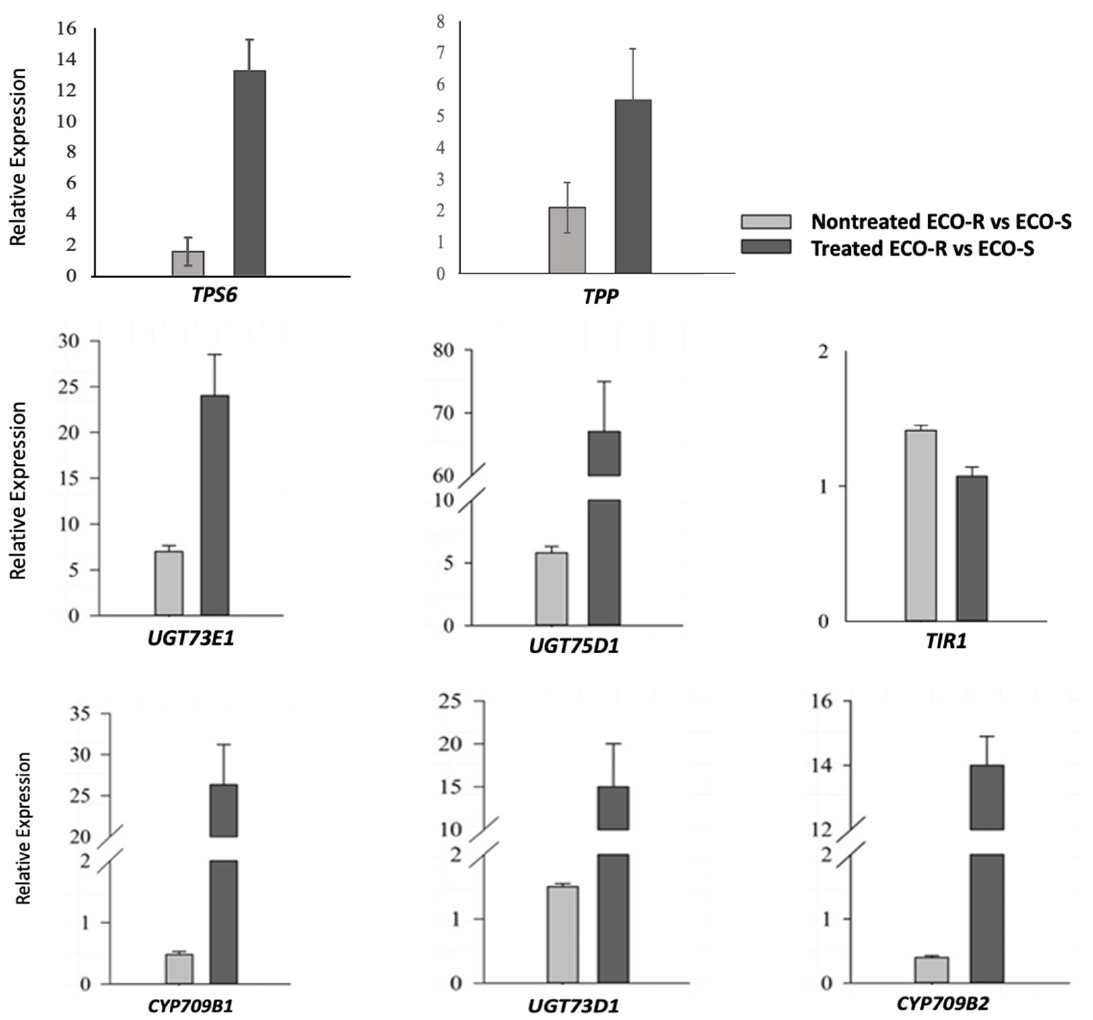
Figure 4. Validation of the expression of eight candidate genes by RT-qPCR.